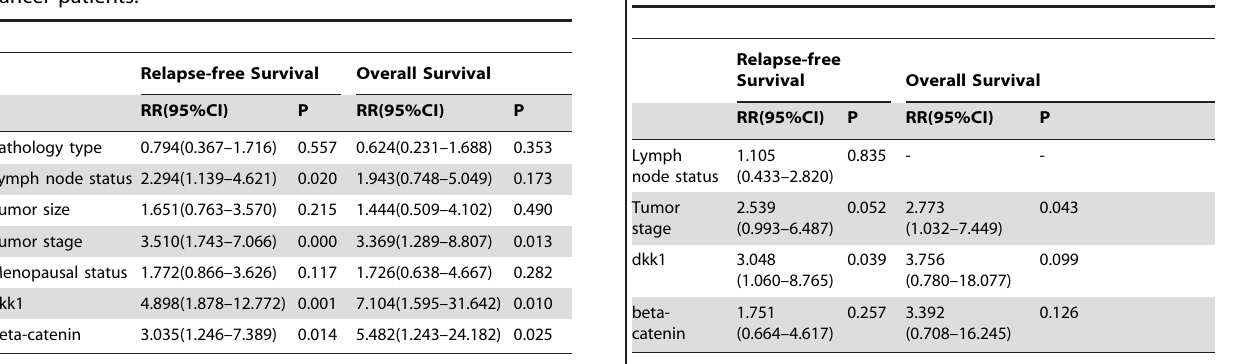
Figure 3. Kaplan-Meier curves based on DKK1 and beta-catenin expression. A) B): Kaplan-Meier estimates for relapse-free survival and overall survival based on DKK1 status. C) D): Kaplan-Meier estimates for relapse-free survival and overall survival based on beta-catenin status. E) F): Kaplan-Meier estimates for relapse-free survival and overall survival based on DKK1 and beta-catenin status.